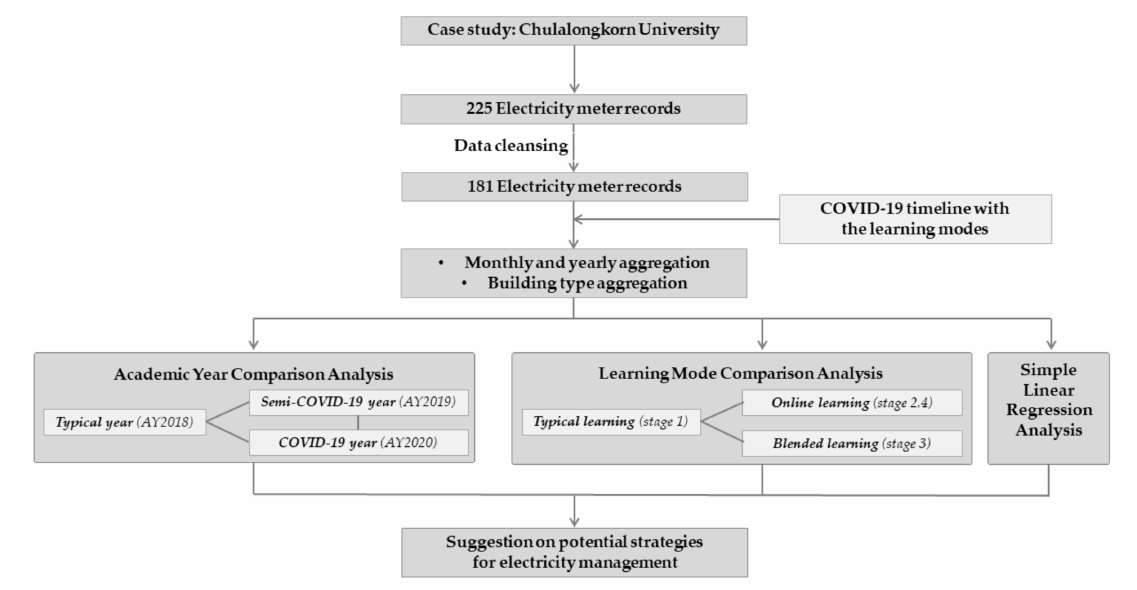
Figure 1. The overall analysis